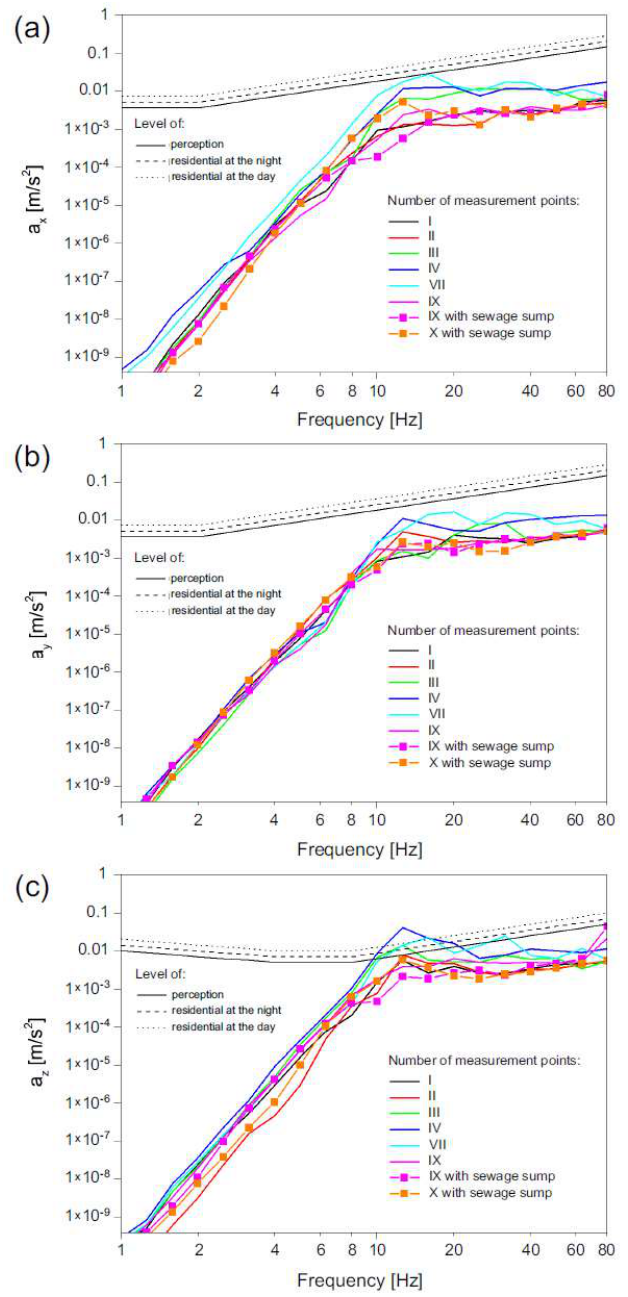
Figure 11. RMS acceleration level (speed of 40 km/h) at selected points in: ( a ) x direction (transverse to the road axis), ( b ) y direction (lateral to the road axis), ( c ) z direction (vertical acceleration).